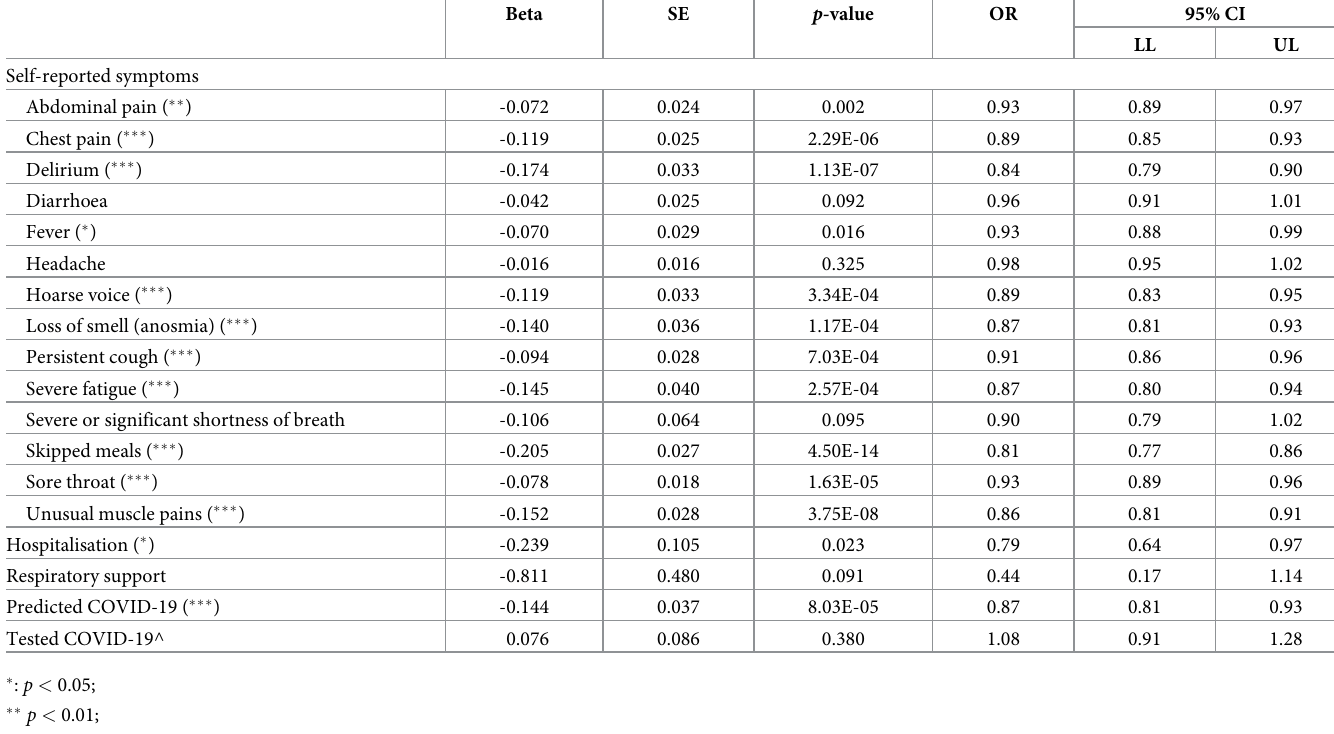
Table 2. Association of COCP use to predicted and tested COVID-19 results, self-reported symptoms, and indicators of COVID-19 disease severity (hospitalisa- tion/respiratory support) (n = 295,689). Beta